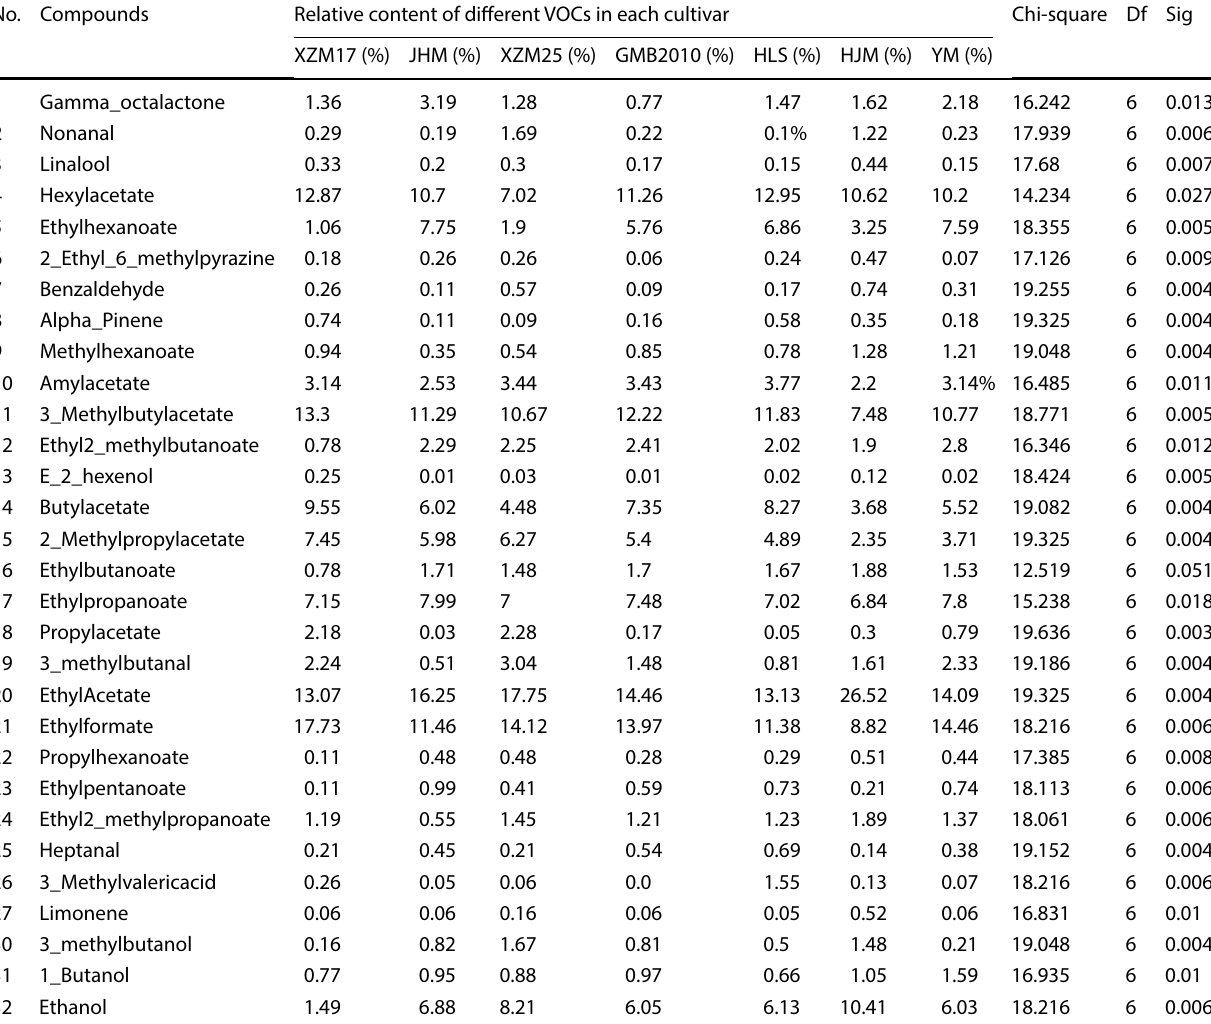
Table 2 Relative content of different VOCs in each cultivar No. Compounds Relative content of different VOCs in each cultivar Chi-square Df Sig